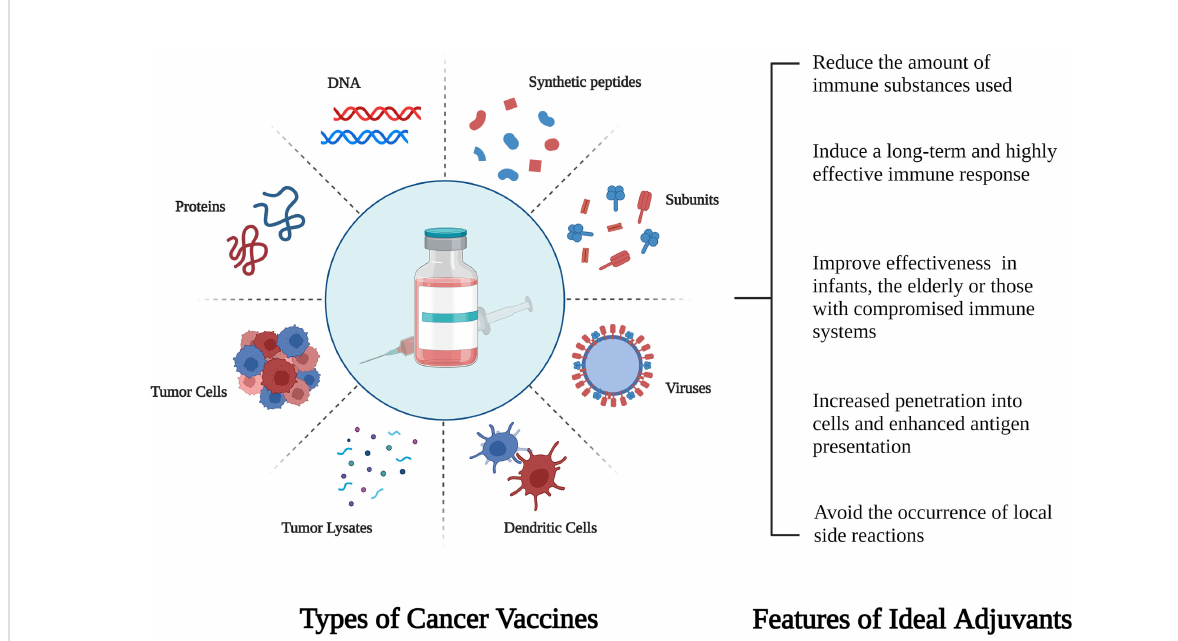
FIGURE 1 Schematic diagram of different types of cancer vaccines and characteristics of new